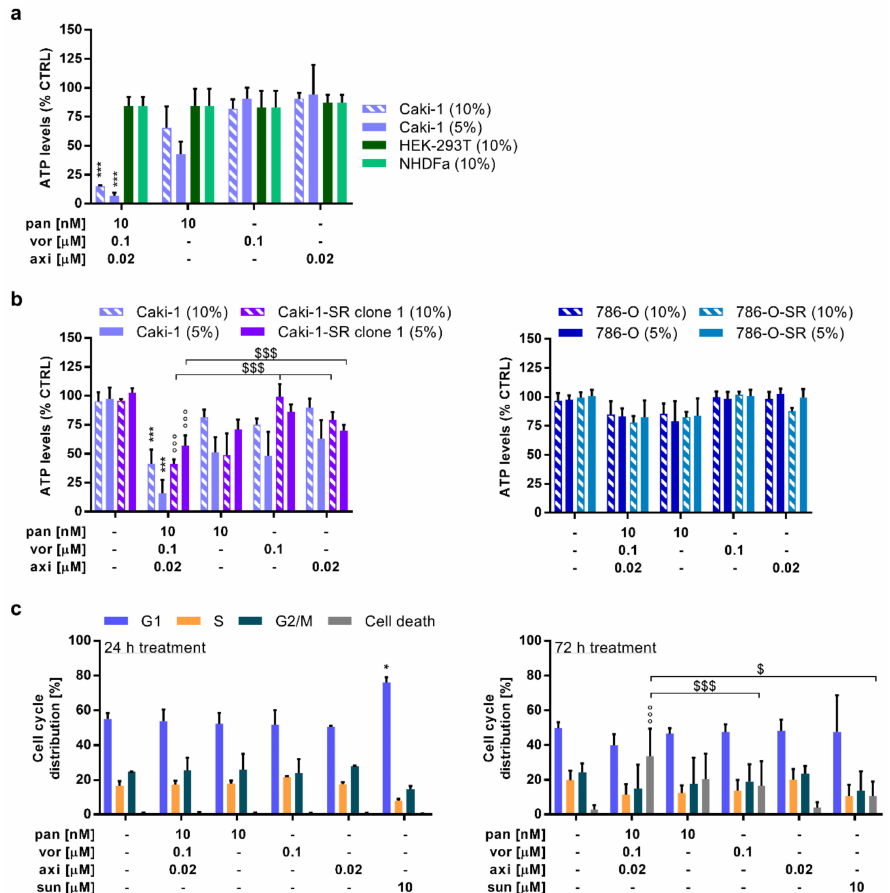
Figure 2. Assessment of the optimized drug combination (ODC) activity: selectivity profile, the e ffi cacy to overcome sunitinib-acquired resistance, and the induction of cell death. ( a ) Cross-validation of the multidrug combination and the corresponding monotherapies in Caki-1 cells and non-malignant HEK-293T cells, and human fibroblasts (NHDF α ). The treatment was applied on Caki-1 cells in medium supplemented with either 5% or 10% fetal bovine serum and on the non-malignant cell lines with 10% fetal bovine serum. ( N = 3) ( b ) Validation of the anticancer activity in sunitinib-resistant (-SR) Caki-1 cells, as well as primary ccRCC cell line 786-O and 786-O-SR cells. ( N = 3) ( c ) Flow cytometry analysis elucidating G1, S, G2 / M phase, and cell death with DNA binding propidium iodide (PI) after treating Caki-1 cells for 24 (left graph) and 72 h (right graph). ( N = 3) Error bars represent the SD and the significance of estimated regression coe ffi cients was determined with a one-way ANOVA and is represented with * p < 0.05 and *** p < 0.001 versus the CTRL (0.03% DMSO in culture medium) and the monotherapies. ◦◦◦ p < 0.001 represents significance calculated versus the CTRL only whereas $ p < 0.05 and $$$ p < 0.001 represent significance calculated vs. the monotherapies